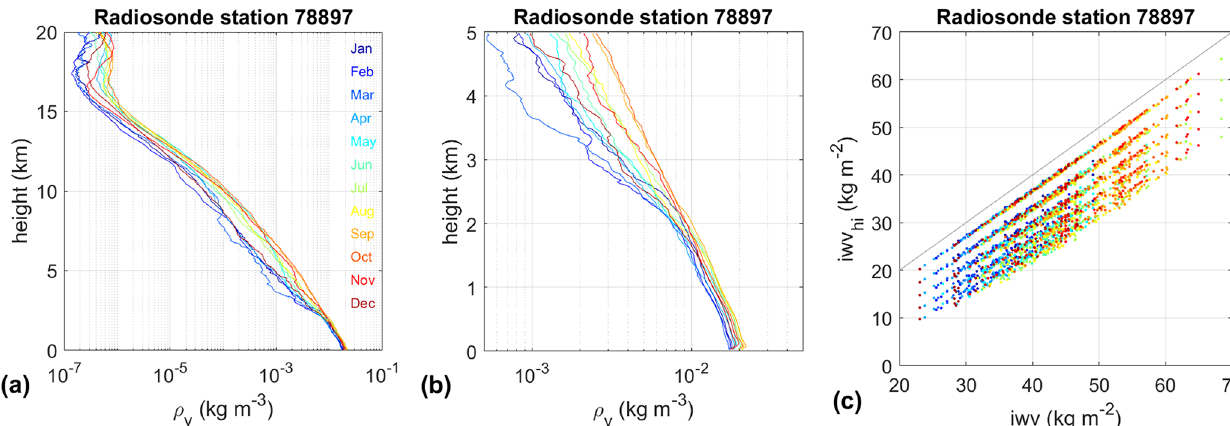
Figure 2. Real water vapour profiles observed by radiosonde station 78897 (Le Raizet, Guadeloupe, France): (a) monthly mean profiles for the year 2020. Panel (b) is similar to (a) for altitudes below 5km. (c) IWV scatter plot, with upper-level IWV plotted on the y axis and total column IWV on the x axis for five different height differences: (cid:49)h = 200, 400, 600, 800, and 1000m. The radiosonde data include 00:00 and 12:00UTC soundings. The colour code indicated in panel (a) is valid for all